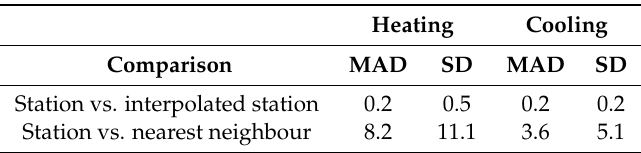
Table 5. Statistical deviation between different data sources calculated according to Equations (5) and (6) for the single-family house. All calculations are for the full 10 years of